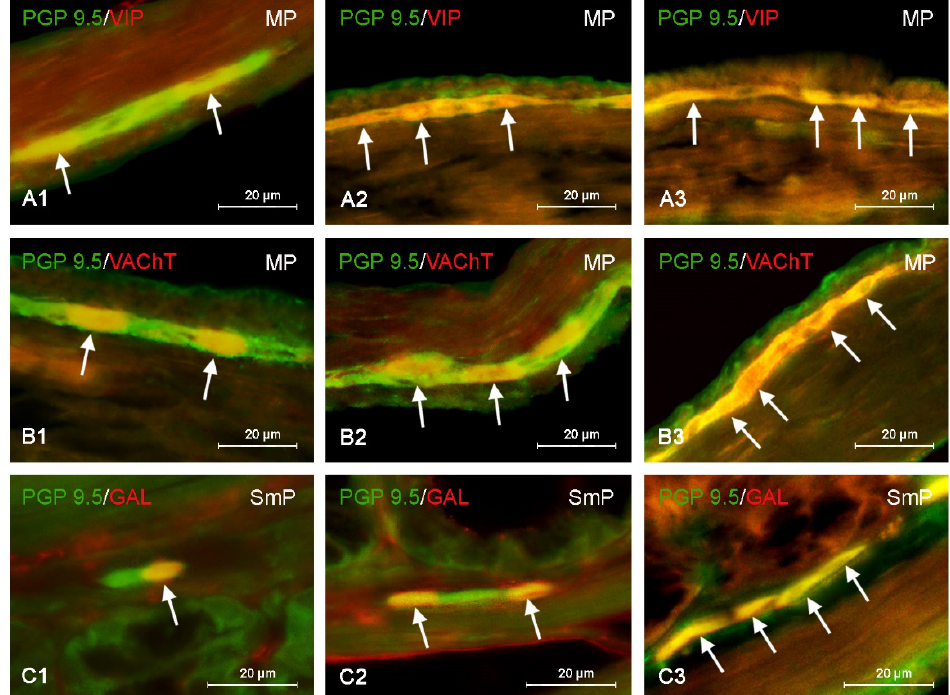
Figure 4. Distribution pattern of nerve cells immunoreactive to protein gene-product 9.5 (PGP 9.5)—used as pan neuronal marker and other substance studied: vasoactive intestinal polypeptide (VIP), vesicular acetylcholine transporter (VAChT) or galanin (GAL) in the myenteric plexus (MP) or submucous plexus (SmP) of mice distal colon under physiological conditions ( A1 , B1 , C1 ) and after administration of bisphenol S in low ( A2 , B2 , C2 ) and high dose ( A3 , B3 , C3 ). The pictures are the result of the overlap of both stainings. The arrows are pointing neurons immunoreactive for studied sub- stances.